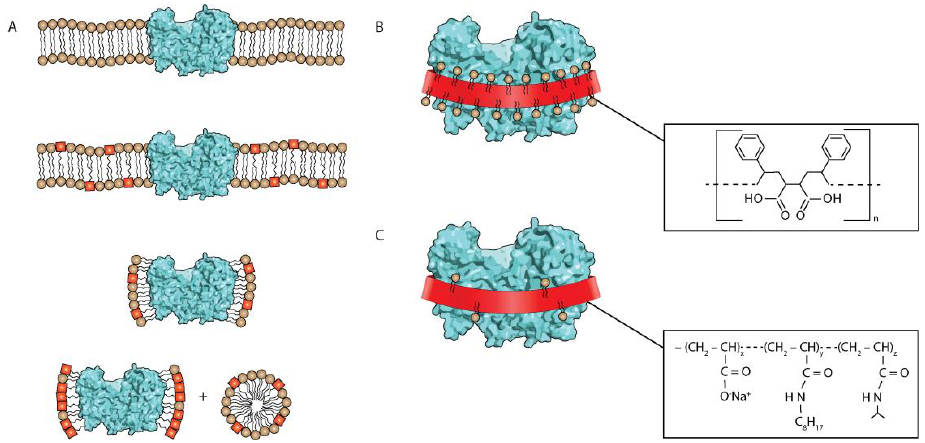
Figure 1. (A) Extraction of a membrane protein (cyan) from the lipid bilayer (lipid heads as circles, tails as lines and detergent molecules as red squares). (From top to bottom) the concentration of detergent is increased, until the protein is extracted in the form of the complex with detergent (and some residual lipids), surrounded by free detergent-lipid micelles. Note that detergent/lipid molecules are omitted in the plane towards a viewer. (B) A membrane protein encircled with the styrene maleic acid (SMA) belt (the chemical structure is shown in the insert). Note that SMA cuts out a fraction of membrane with the protein, thus maintaining the endogenous lipids. (C) A membrane protein encircled with the insert). Since amphipols are applied only after extraction with a detergent, there are far fewer lipid molecules bound to the